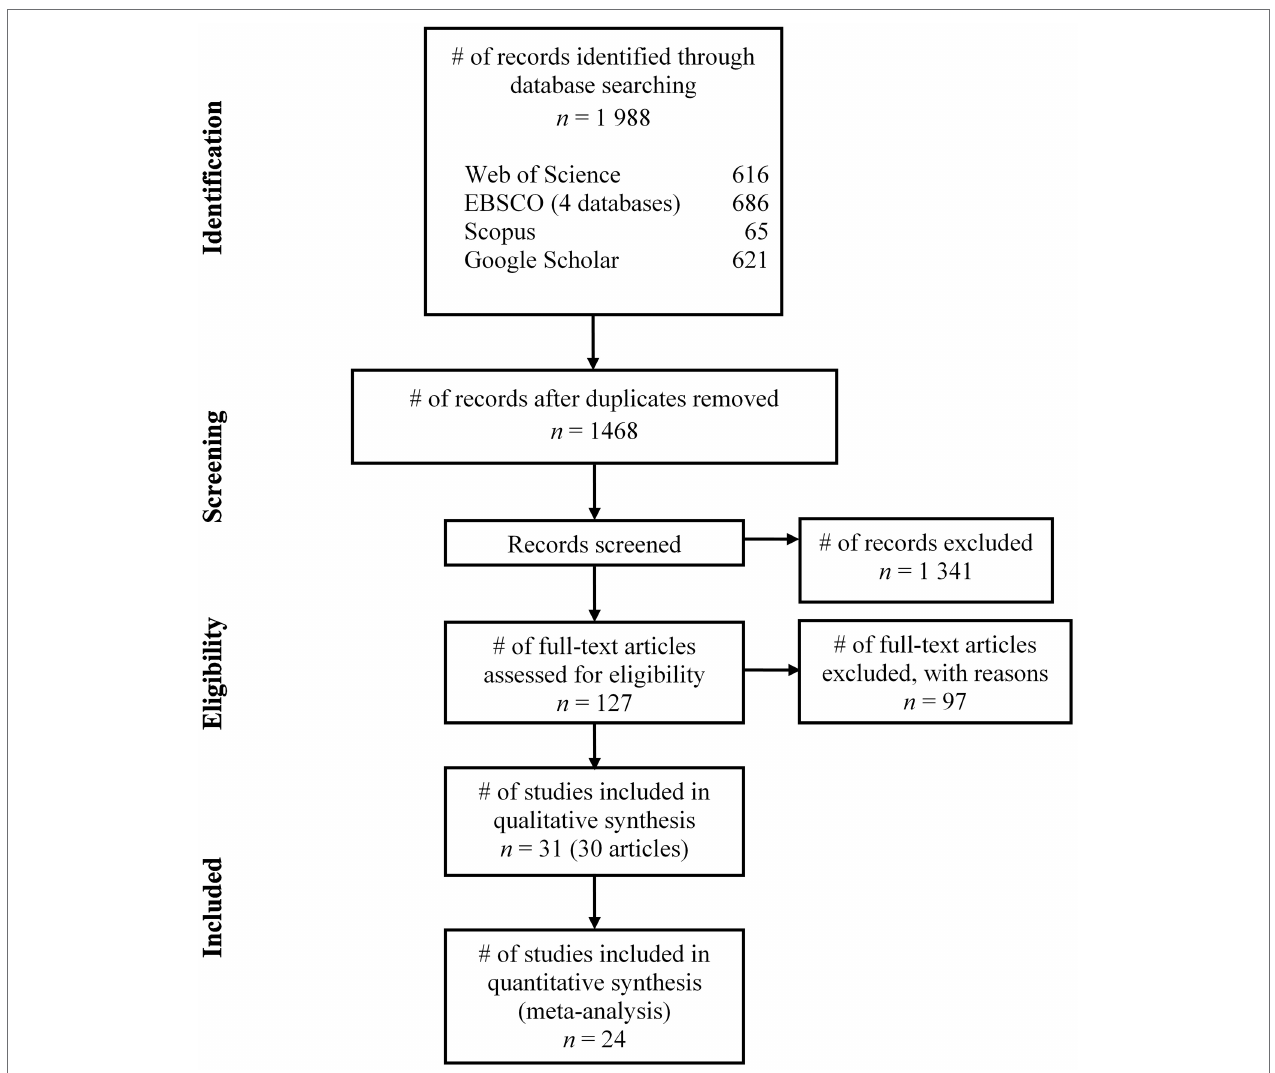
FIGURE 1 | PRISMA flow diagram illustrating the conducted screening and selection process. Source: Moher et al.